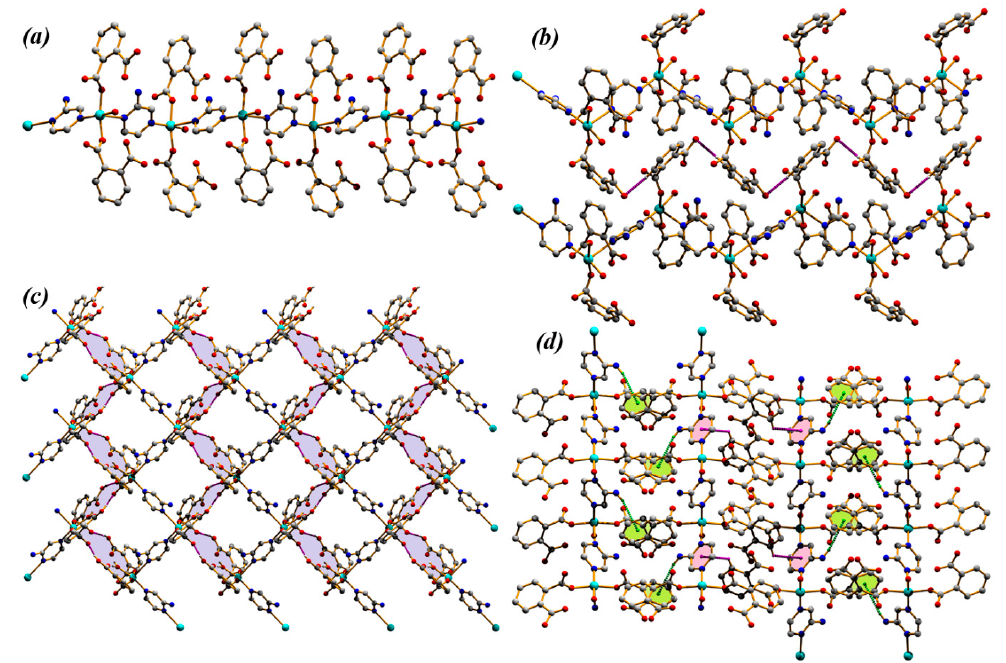
Figure 4. ( a ) Polymeric chain structure in 2 ; ( b ) Interconnection of the parallel polymeric chains; ( c ) Formation of two-dimensional framework where R 22 (22) acts as building block of the structure; ( d ) Layered network in (011) plane where the green dotted lines represent N-H ··· π interaction, whereas the pink dotted lines are indicating C-H ··· π interactions in 2 . In the solid-state structures, the amino group from the 2-aminopyrazine moiety that have higher occupancy factor is taken into consideration to draw the figures. Disordered counterpart of amino group with small occupancy factor is omitted for clarity.